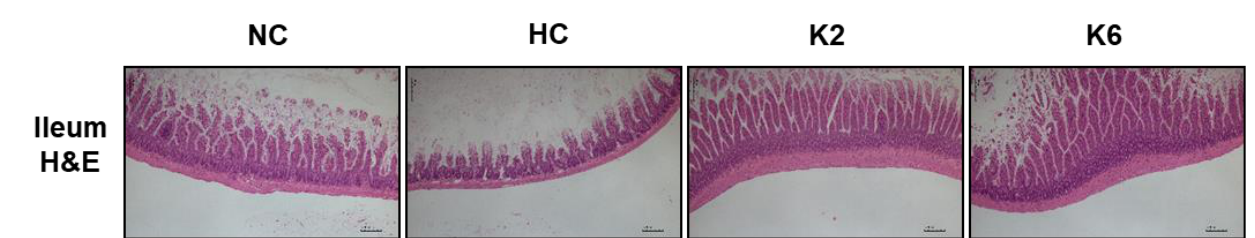
Figure 7. Effect of L. plantarum treatments on the histological morphology of the ileum in the HFHF diet rat. NC, normal diet control; HC, HFHF diet control; K2, HFHF diet with K2; K6, HFHF diet with K6; H&E, Hematoxylin and eosin staining. The scale bar shows 200 μ m.